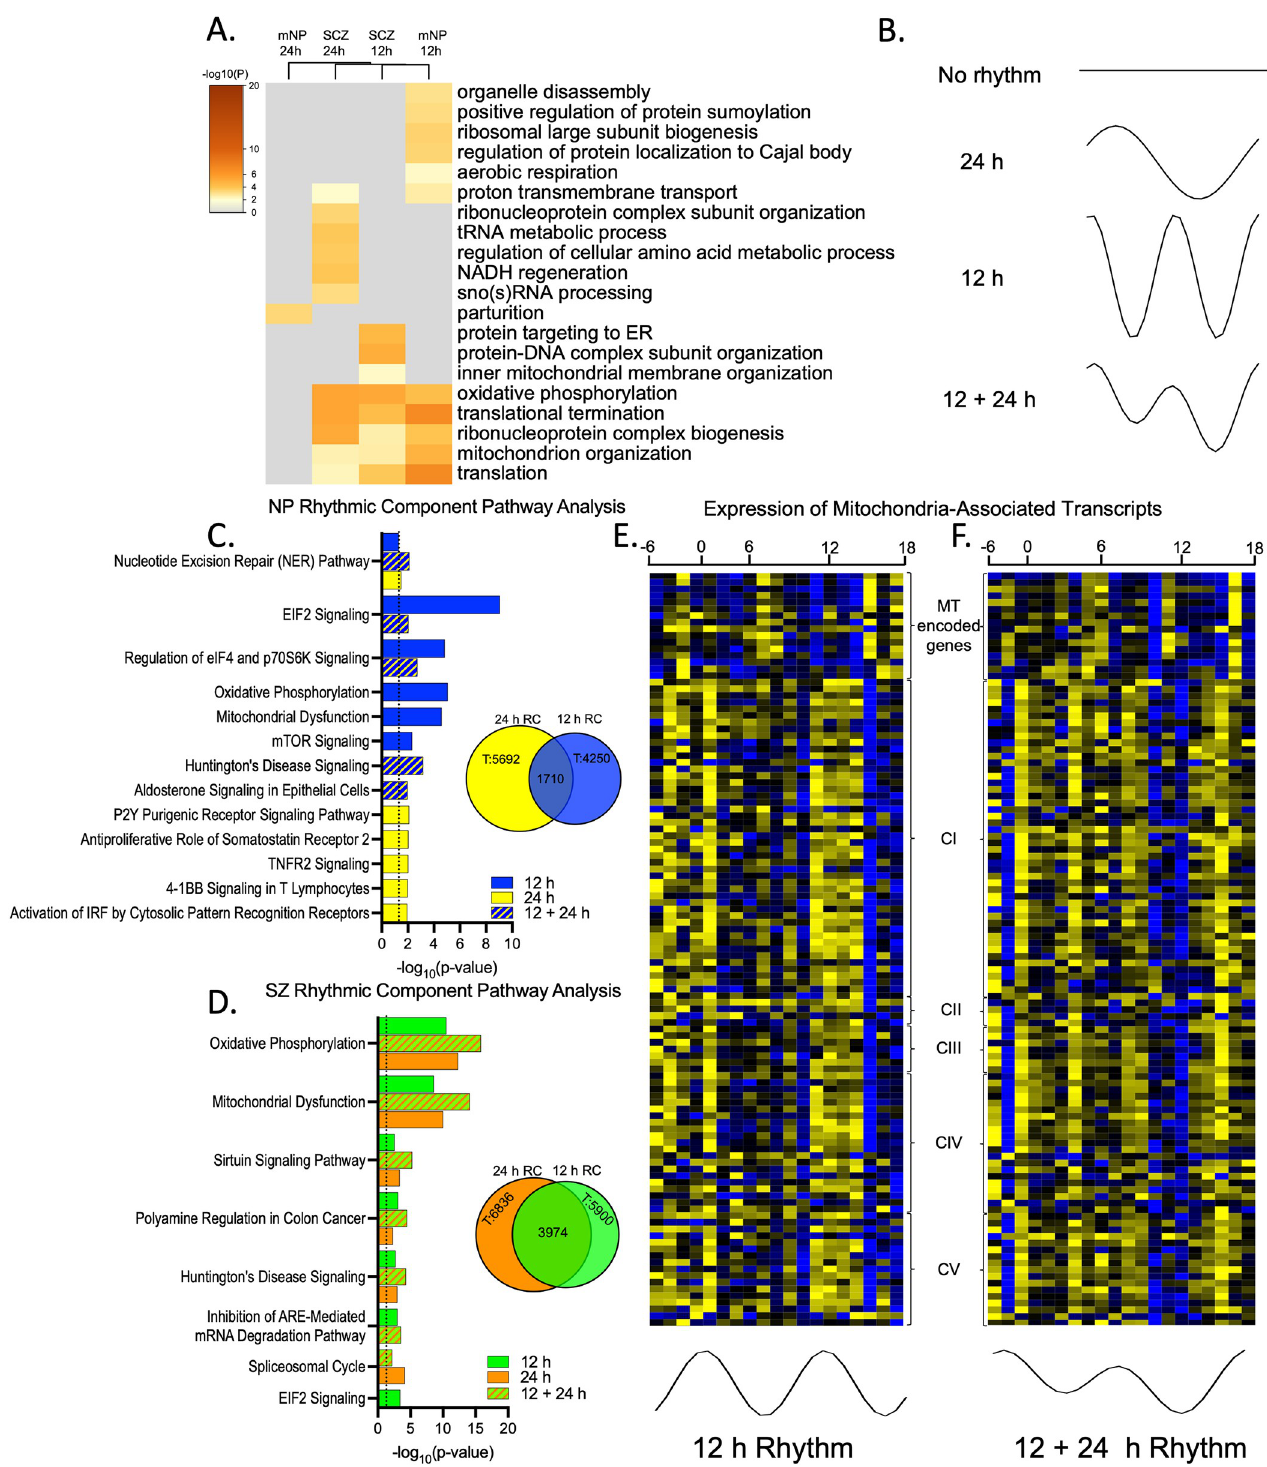
Fig 4. 12 and 24 h rhythms converge on mitochondria-associated transcripts. ( A ) Metascape-derived heatmaps of biological processes enriched for 12 and 24 h rhythms in mNP and SZ cohorts. Full Metascape results can be found in S11 File. ( B ) Illustrations of how transcripts could have no rhythms, a 24 h rhythm, a 12 h rhythm, or a combined 12 and 24 h rhythm. Results of eigenvalue/pencil analysis for mNP and SZ subjects can be found in S12 and S13 Files, while a summary of the 12 and 24 h RCs is detailed in S5 File. ( C - D )IPA of transcripts with 12 h and 24 h RCs in ( C ) mNP subjects and ( D ) subjects with SZ. IPA results can be found in S7 File. ( E - F ) Gene expression heatmaps of subunits from the MT electron transport chain complexes (CI-CV) across time of day